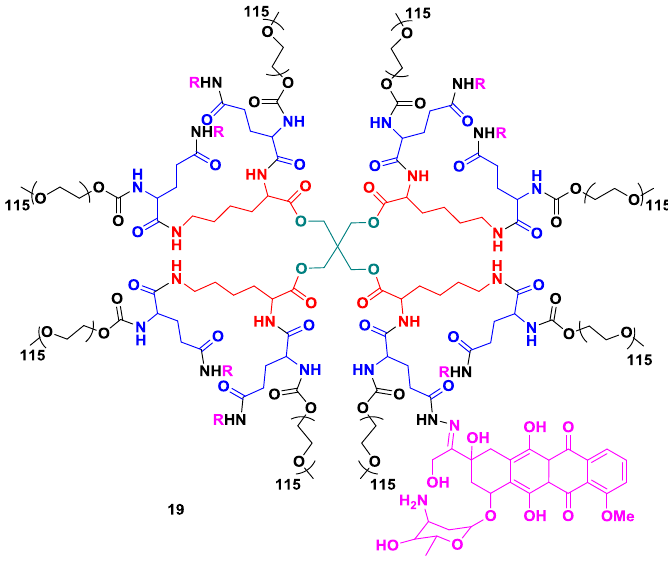
Figure 8. A drug (DOX) loaded PEGylated ester-amide dendrimer